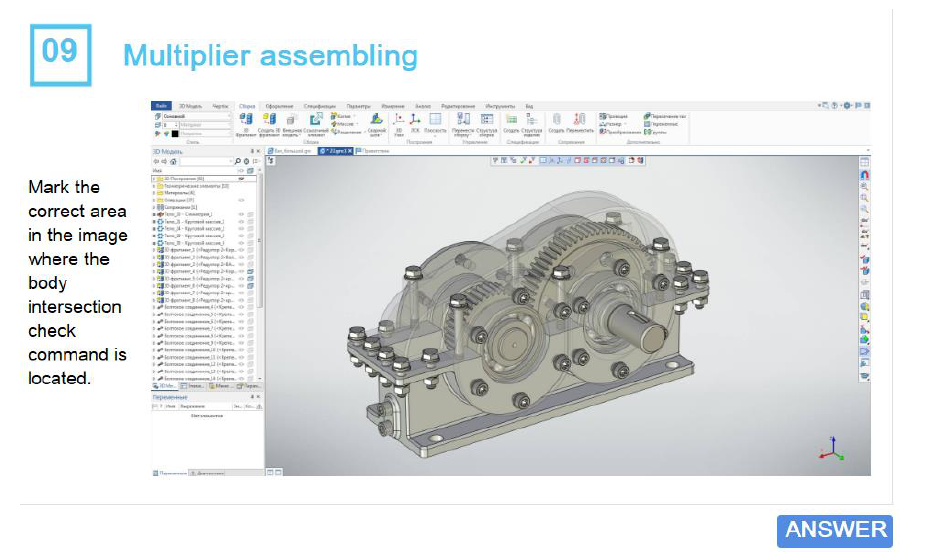
Fig. 17. The final test